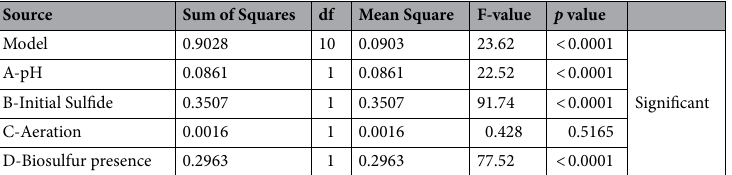
Table 5. ANOVA for quadratic model. Statistical data of model: Std. Dev.: 0.0618. R 2 = 0.97. R 2 Adjusted: 0.92. Mean =